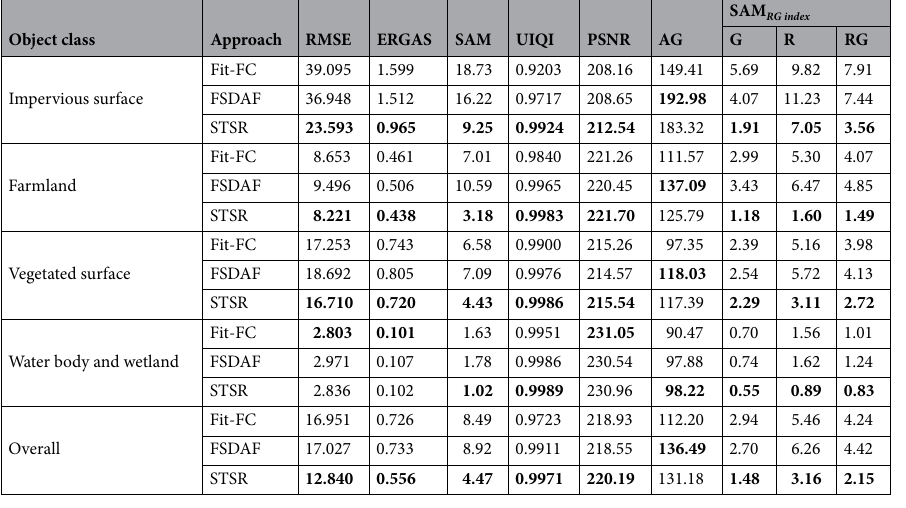
Table 2. Image fusion quantitative metrics for spatiotemporal problem for 12-bit MSI and OLI at two different acquisition times over different object classes for the Khorasan-e Razavi dataset. Significant values are in bold.